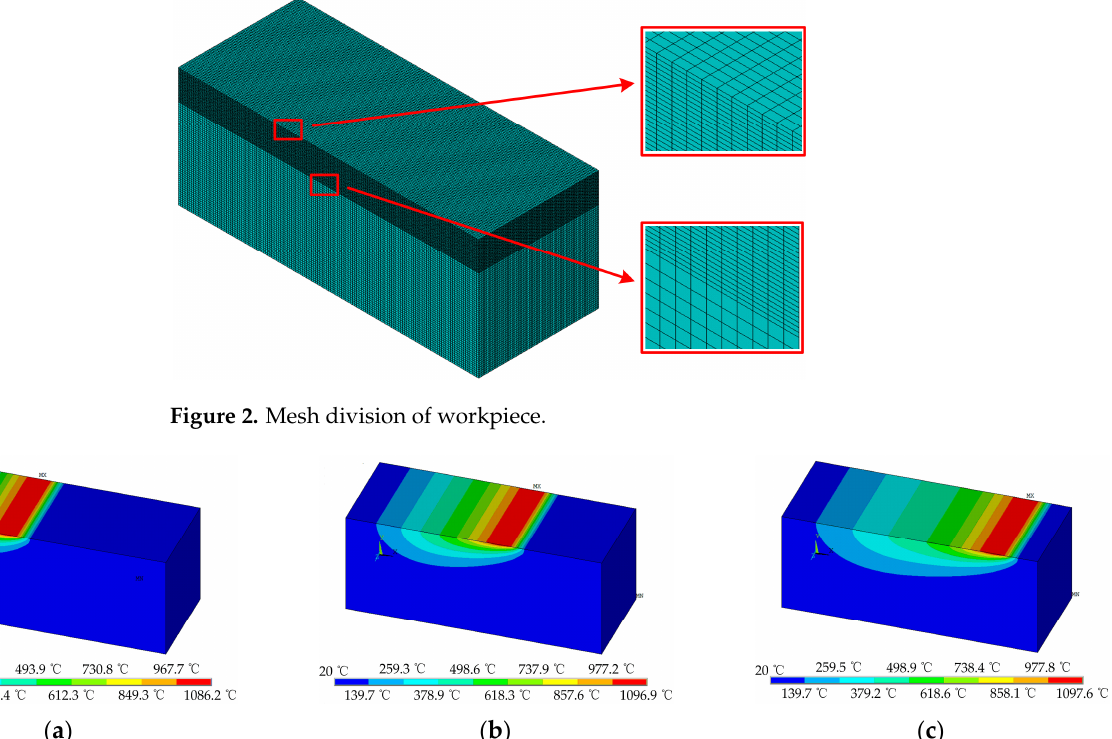
Figure 2. Mesh division of workpiece.